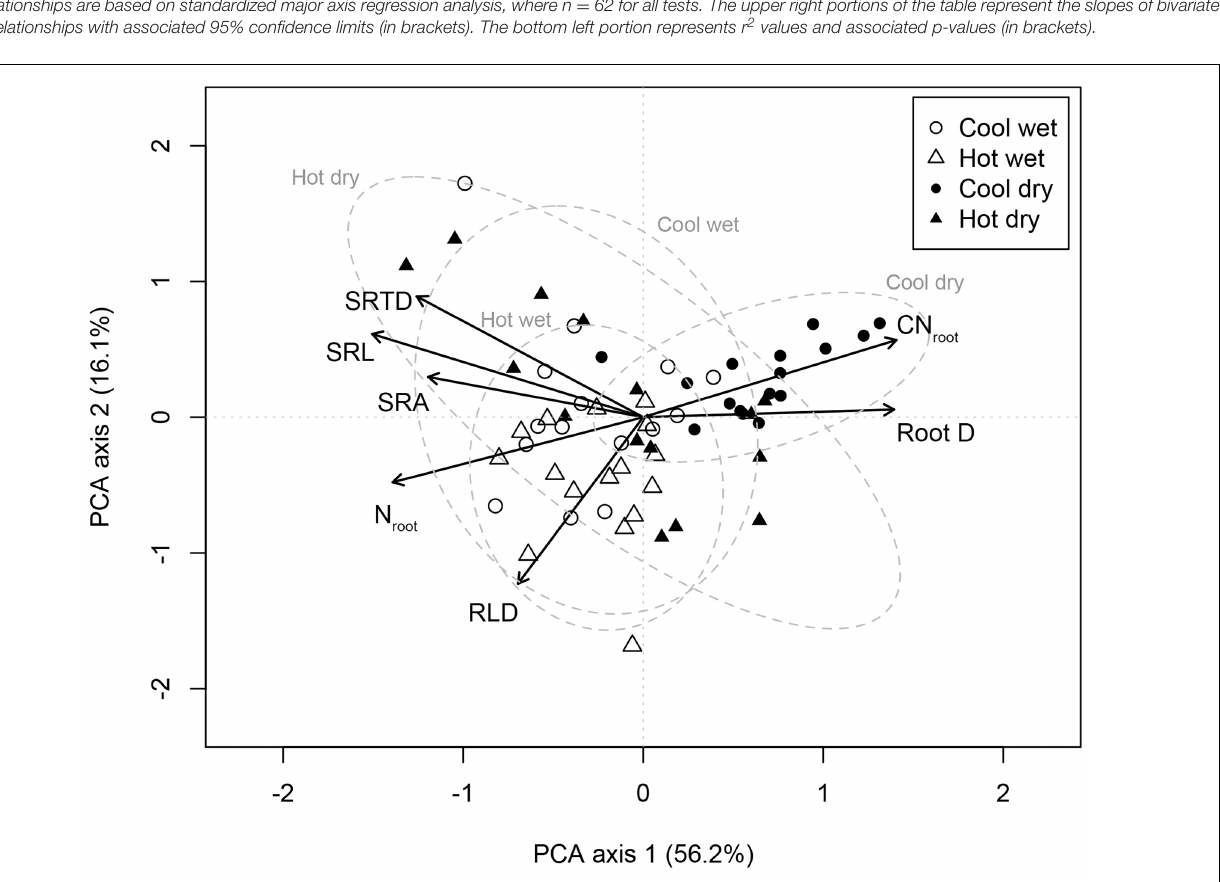
resource conservation; PCA axis 1 scores were also significantly ( p < 0.001) related to site category. PCA axis 2 explained a further 16.1% of the variation in the seven root traits among C. arabica plants ( Figure 1